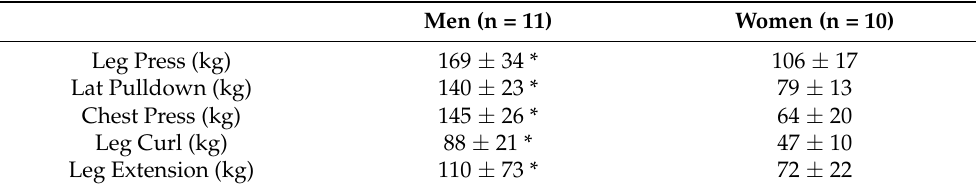
Table 1. Descriptive characteristics of participants gathered during initial testing for both active men and women (n = 21). Men (n = 11) Women (n = 10) Height (m) 1.8 ± 0.1 * 1.6 ± 0.1 Weight (kg) 79 ± 14 * 60 ± 7 Age (years) 23 ± 3 22 ± 3 BMI (kg · m 2 ) 25.3 ± 2.5 23.1 ± 1.4 Years Training (years) 3 ± 2 2 ± 2